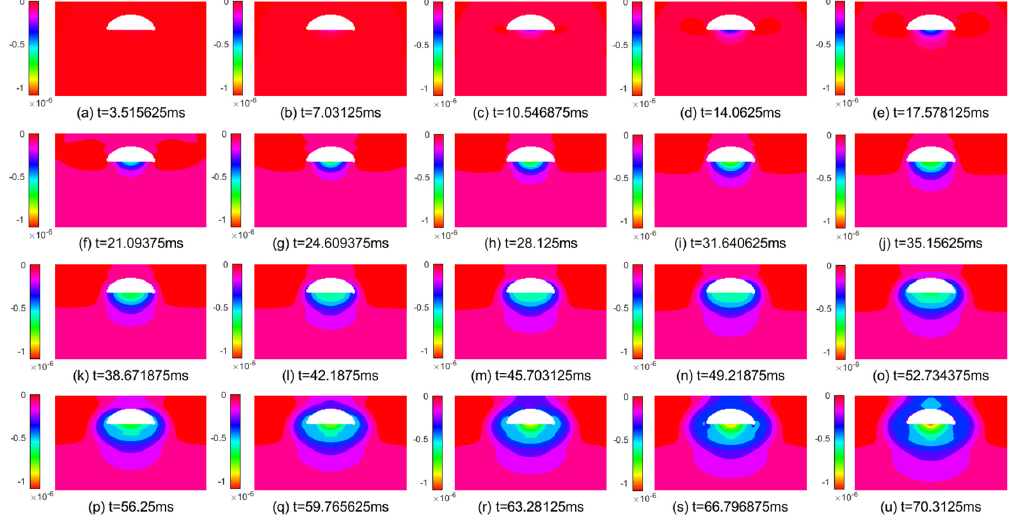
s σ at ( − 2, − 7) and ( b ) p at (1, − 7) under different sampling numbers